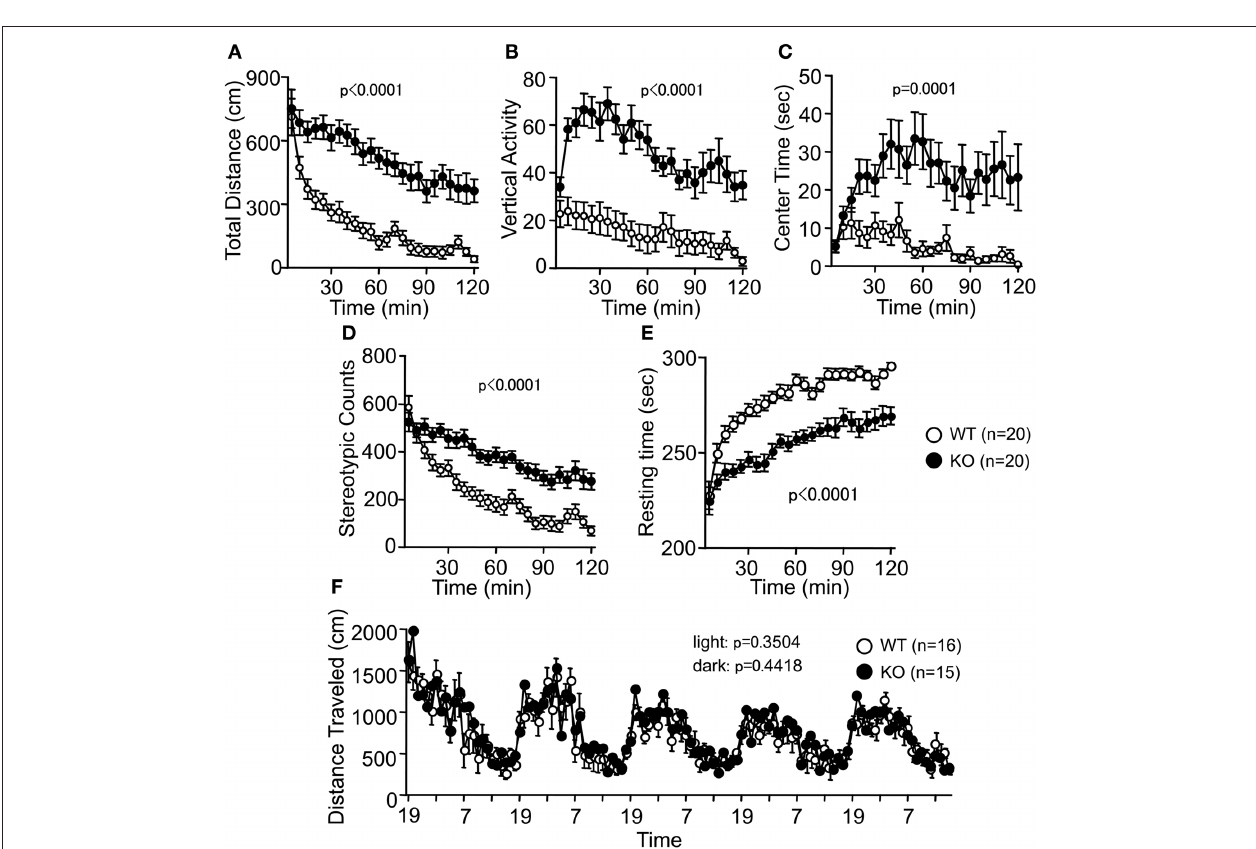
prepulse inhibition (C) were shown. Data are presented as means ± SEM for the indicated numbers of animals. The p -values indicate genotype effect in two-way repeated measures ANOVA.